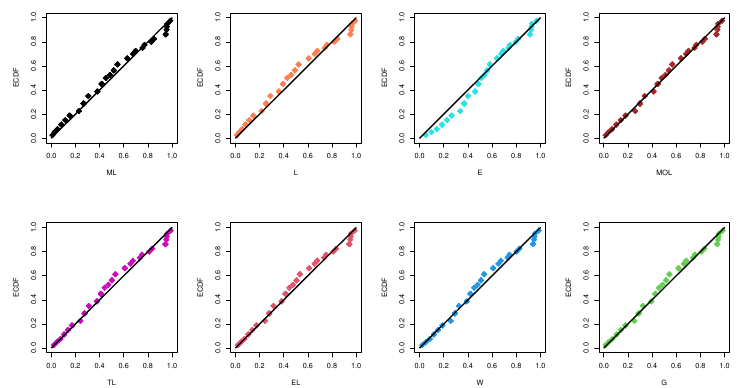
Figure 8. The QQ plots of ML and its competitive models from MVAD data.